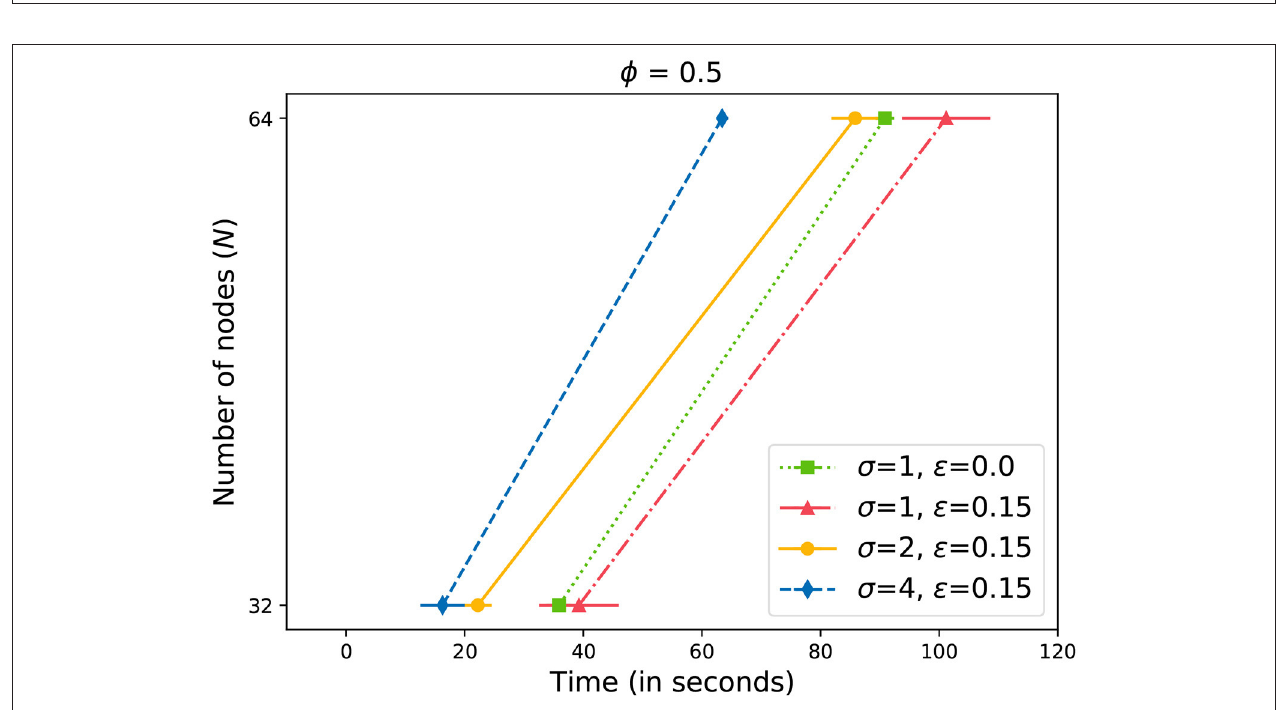
FIGURE 7 | Time to gossip a message with 15% failed